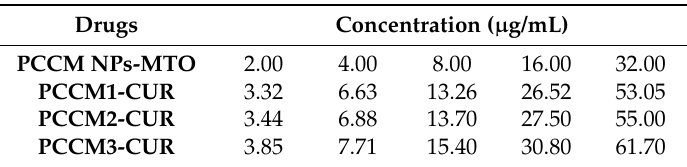
Table 2. The concentrations of mitoxantrone (MTO) and chemotherapy (CUR) in PCCM NPs on the treatments of HepG2